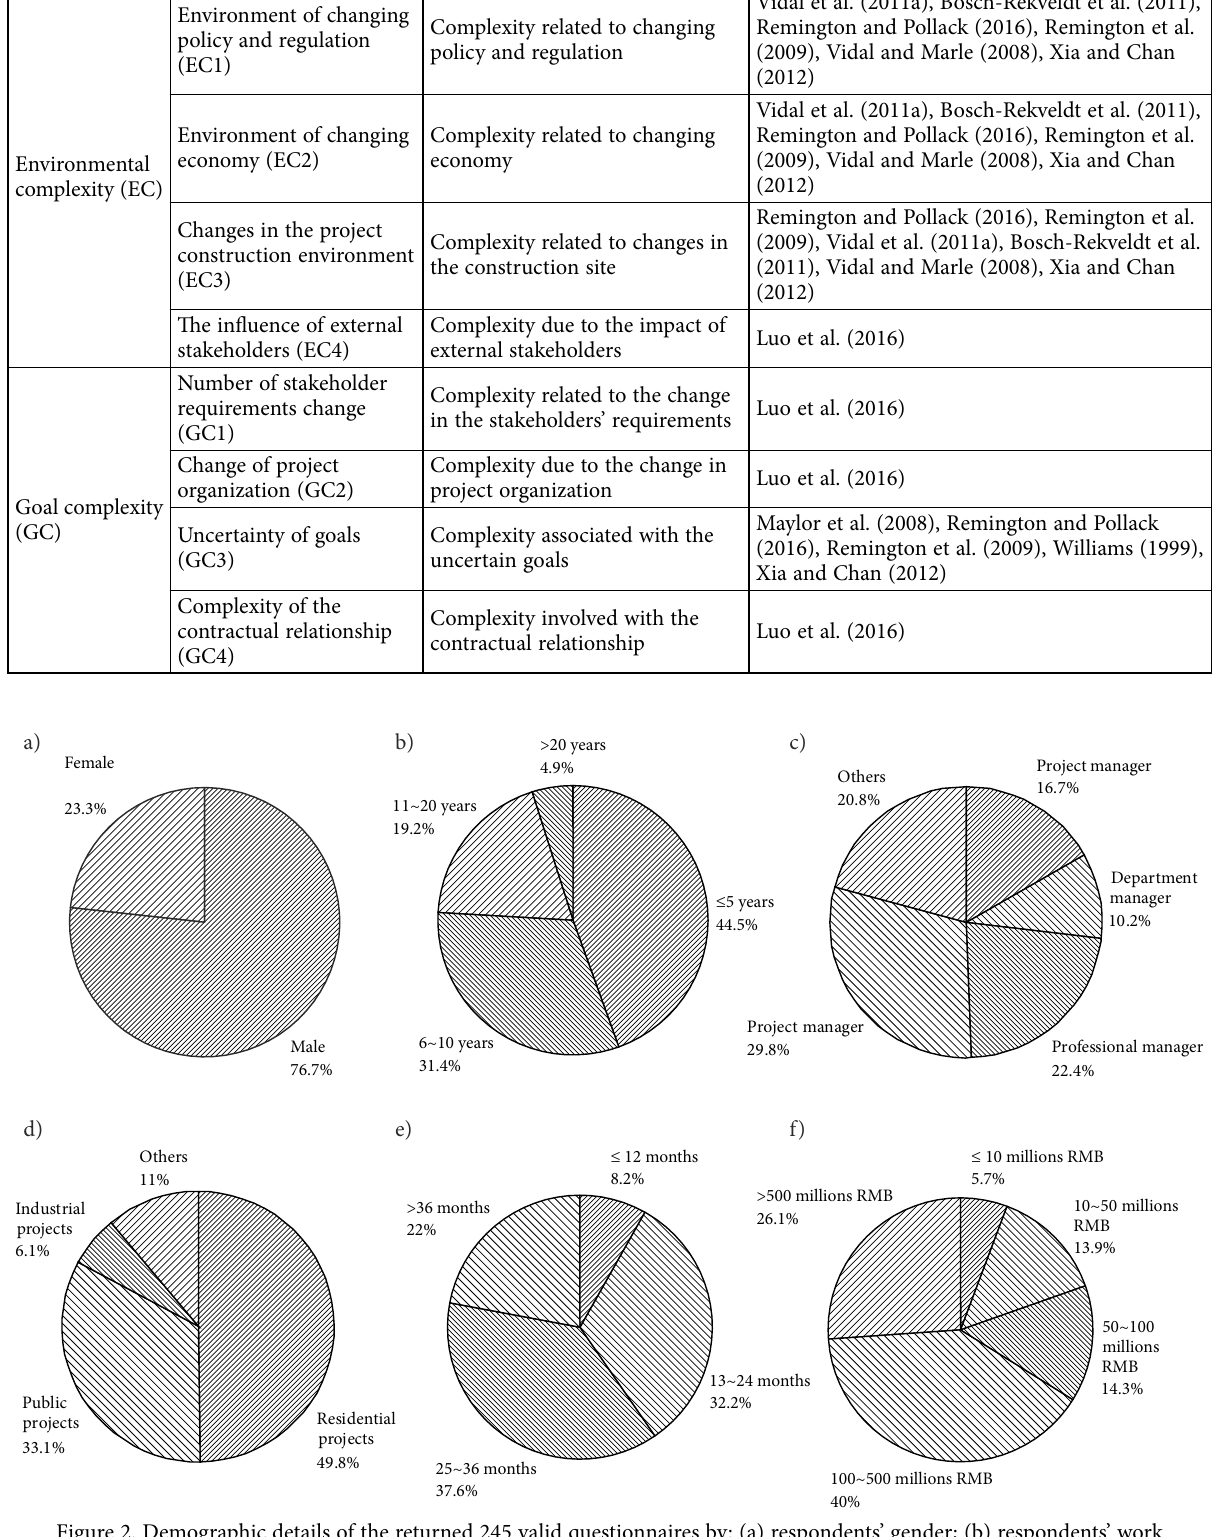
Figure 2. Demographic details of the returned 245 valid questionnaires by: (a) respondents’ gender; (b) respondents’ work experience; (c) respondents’ designation; (d) project type; (e) project duration; (f) project size